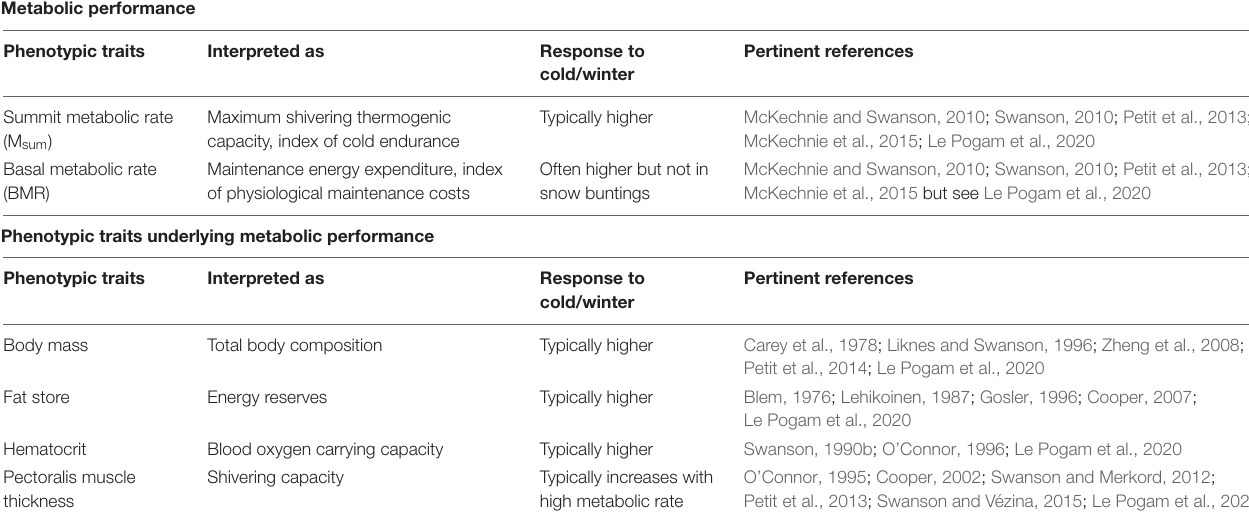
TABLE 1 | List of phenotypic traits measured in this study and their responses to cold and winter in passerine